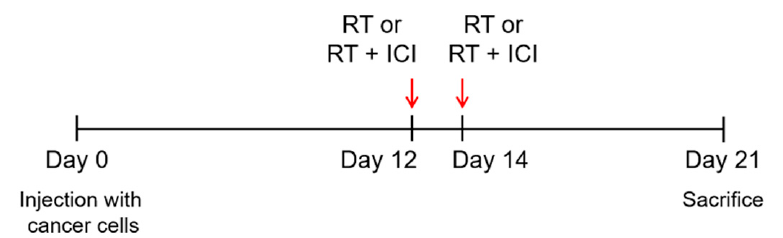
Figure 5. Experimental Schema. Mice were injected s.c. in both flanks with 5 × 10 4 4T1 cells on day 0. Treatment was initiated on day 12 from the day of cancer cell inoculation. RT with two fractions of 10 Gy given at a 48 h interval was delivered to a field including the tumor with 5 mm margins. Mice assigned to the ICI group were intraperitoneally administered a fixed dose of 200 µ g anti-PD-1 antibody twice at a 48 h interval. All mice were sacrificed on day 21 post-tumor inoculation. Tumor growth was evaluated every 2 or 3 days until the mice died or were sacrificed. All mice were sacrificed on day 21 post-tumor inoculation, and the incidence of lung metastasis was examined by counting the number of metastatic foci on the lung surface after